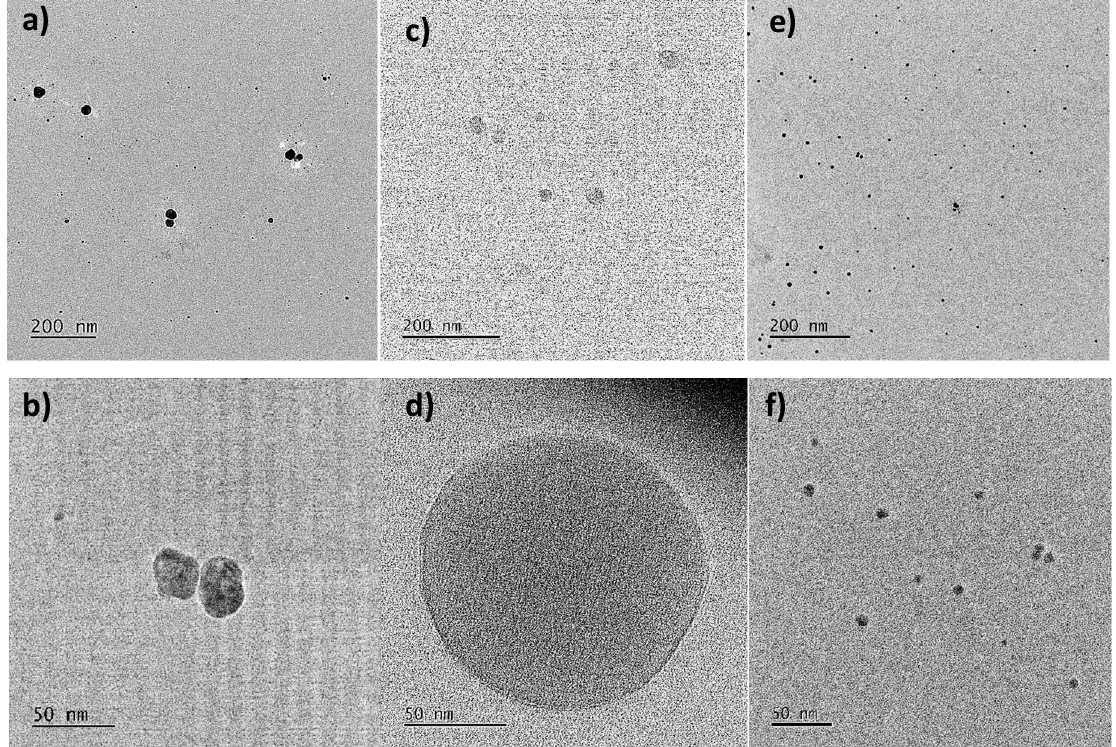
Figure 5. Transmission electron microscopy (TEM) images of AgNPs synthesized in reaction mixtures of different pH. ( a ) and ( b ) pH 12; ( c ) and ( d ) pH 10; ( e ) and ( f ) pH 6.